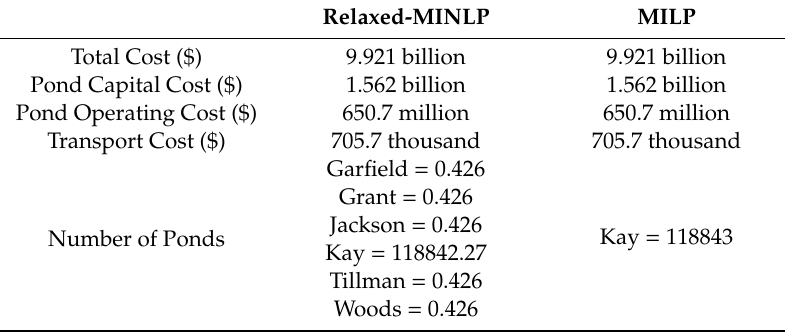
Table 6. Comparison of the solutions from relaxed-mixed-integer nonlinear program (MINLP) and mixed-integer linear programming (MILP) solvers: CONOPT 3 version 3.17A and CPLEX version 12.6.3.0 for the case of